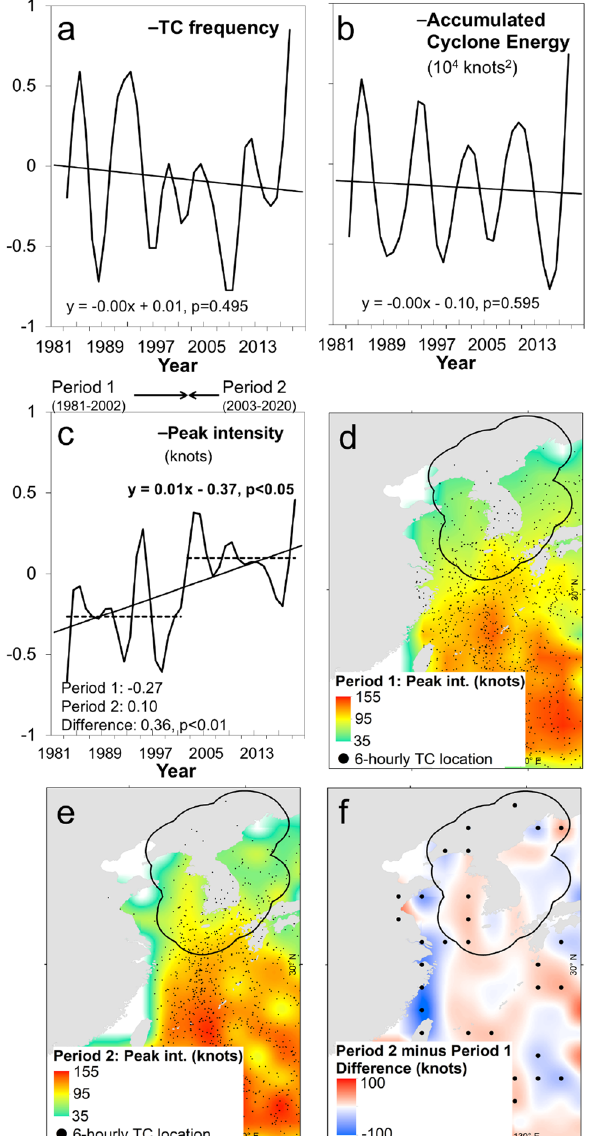
Figure 2. Increase in peak intensity of tropical cyclones (TCs) passing through the Korean Peninsula (KP). ( a )–( c ), Timeseries of indicated TC metrics during June-October. All timeseries are filtered using the 1-3-4–3-1 technique. In c, the dashed lines and inset statistics indicate the mean values of peak TC intensity during Period 1 (1981–2002) and Period 2 (2003–2020), respectively. ( d ), ( e ), Composite map of peak TC intensity gridded into 2° × 2° horizontal resolution during Period 1 (1981–2002) and Period 2 (2003–2020), respectively. The black dots indicate six-hourly TC location. ( f ) Composite difference in peak TC intensity between Period 2 and Period 1, respectively. The dots indicate significance at p < 0.05. In ( d )–( f ), the black contour line indicates the 250 km buffer zone away from the KP. In d-f, the maps are plotted using ArcGIS 10.1 (https:// www. esri.